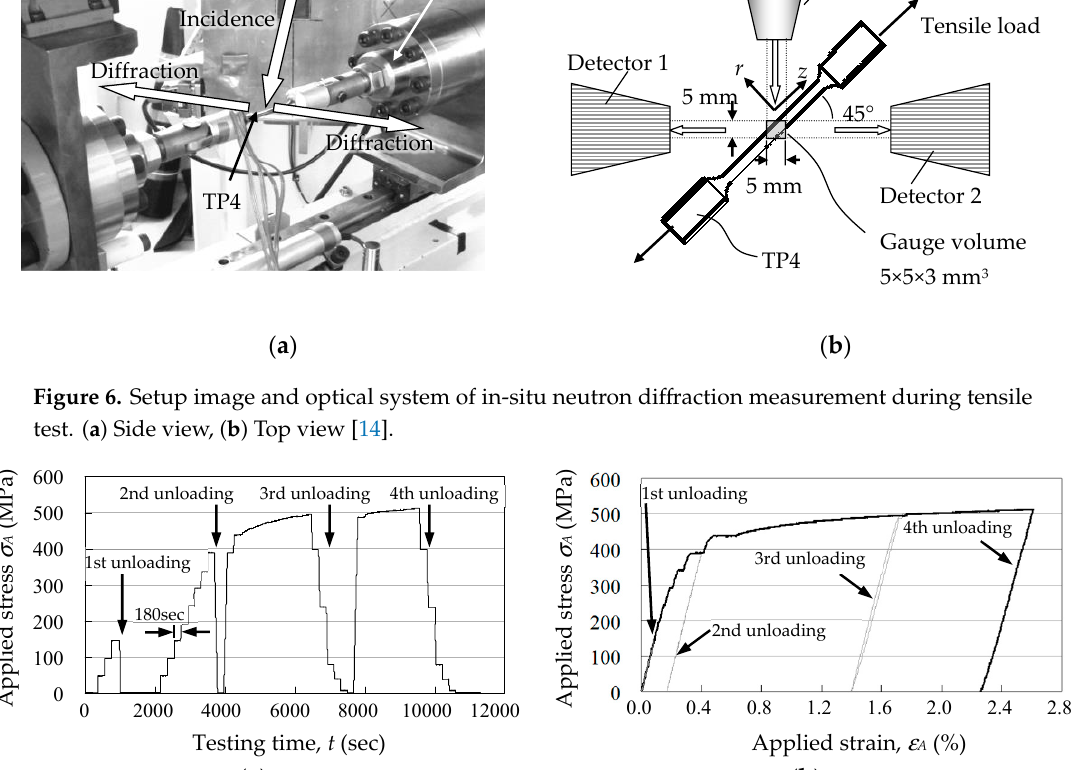
Figure 7. Loading condition of tensile test. ( a ) Applied stress history, ( b ) Stress-strain curve [14].